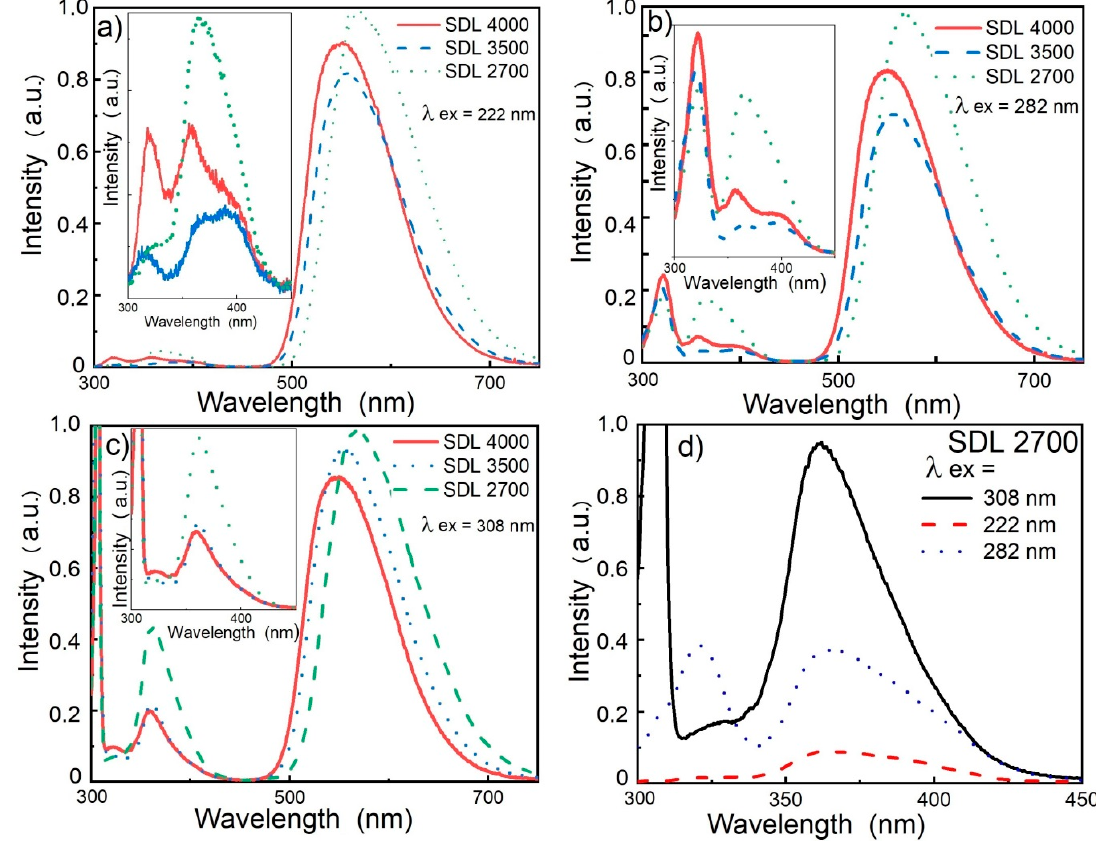
Figure 5. Luminescence spectra of SDL phosphors under excitation by excimer lamp radiation with ( a ) λ = 222, ( b ) 282, and ( c ) 308 nm; ( d ) luminescence spectra in phosphor SDL 2700 under excitation by different excilamp radiation.